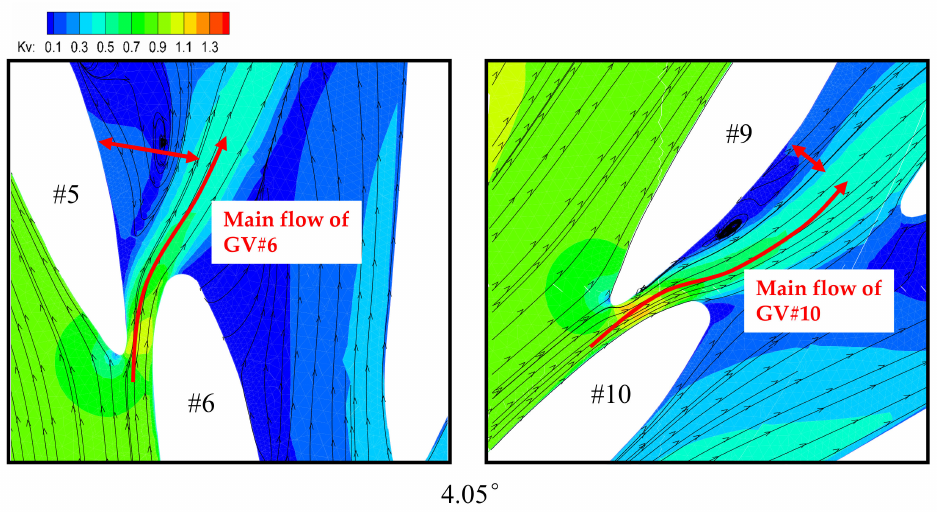
Figure 15. Comparison of deflection speeds between the main flow of GV10 ( right ) and that of GV06 ( left ) at GVO = 4.05 ◦ .